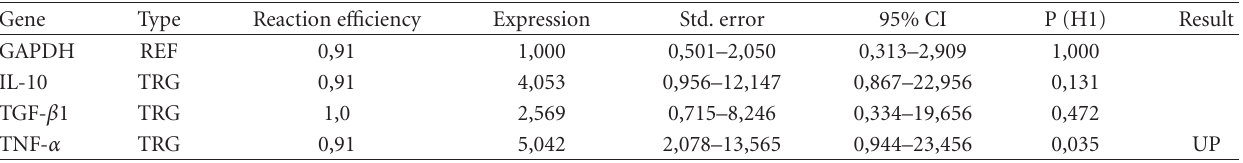
Table 1: Statistical analysis summary of results obtained from echinacea versus control after processing RT-PCR data through REST (Relative Expression Software Tool) in 20th day.